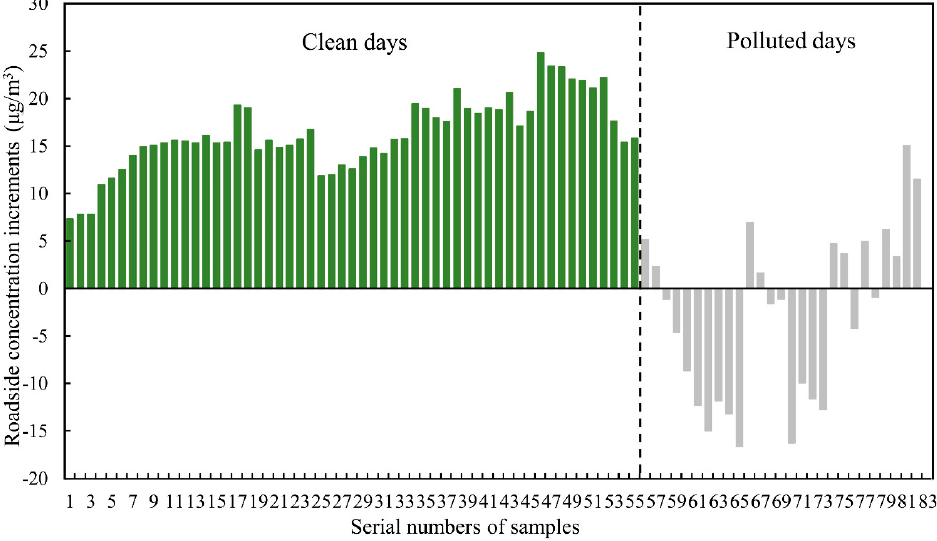
Figure 3. Roadside concentration increments ( μ g/m 3 ) on clean days and polluted days.